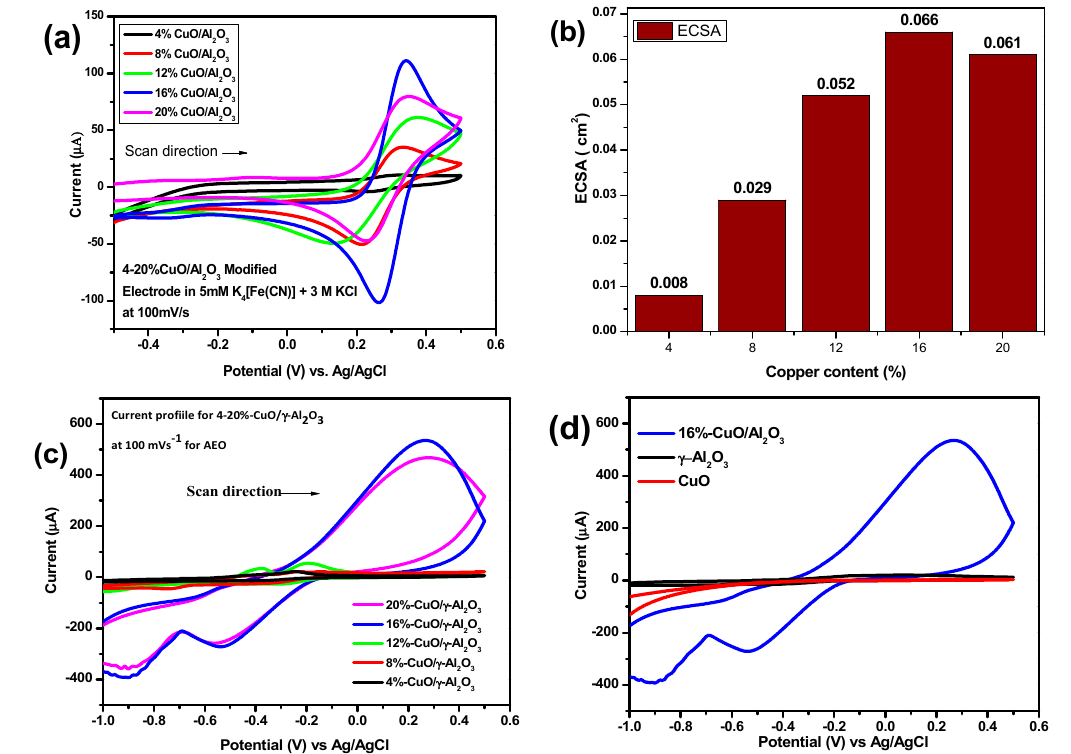
Figure 6. Cyclic voltammetric profiles on 4%–20%-CuO/ γ -Al 2 O 3 modified electrodes materials in (5.0 mM K 4 [Fe(CN) 6 ] + 3.0 M KCl) solution at scan ate of 100 mV·s − 1 ( a ) and comparison of ECSA ( b ), Comparison of AEO in 0.1 M KOH + 1.0 M NH 3 at 100 mV·s − 1 ( c ) and 16%-CuO/ γ -Al 2 O 3 with bare CuO and γ -Al 2 O 3 ( d ).